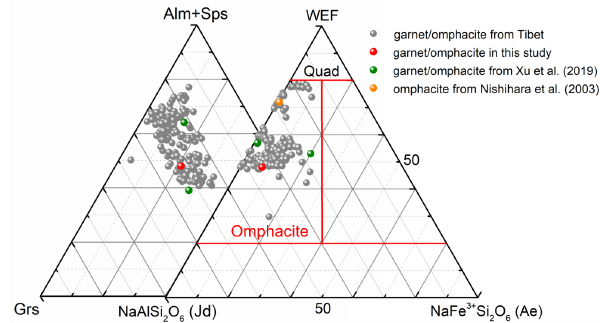
Figure 2. Composition of garnet and omphacite in eclogites from Tibet and this study. The gray solid circles represent the compo- nents of garnet and omphacite collected from previous studies in Tibet (e.g., Chan et al., 2009; Liu et al., 2019; Song et al., 2003; Weller et al., 2016; Yang et al., 2009; Zhai et al., 2011a). The green solid circles are garnet and omphacite with different Fe contents according to Xu et al. (2019). The orange solid circles are om- phacite according to Nishihara et al. (2003). The red solid circles are the components of garnet and omphacite in this study. Prp: py- rope, Alm: almandine, Grs: grossular, Sps: spessartine, Quad: fer- rosilite + enstatite + wollastonite, Jd: jadeite, and Ae: